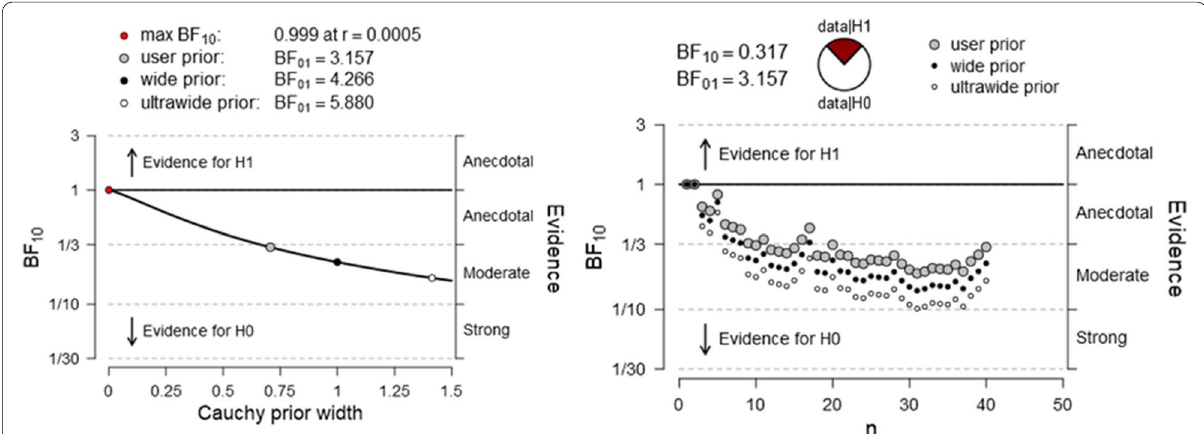
Fig. 5 Bayes factor robustness check for differences between RCT accuracy on digital and paper